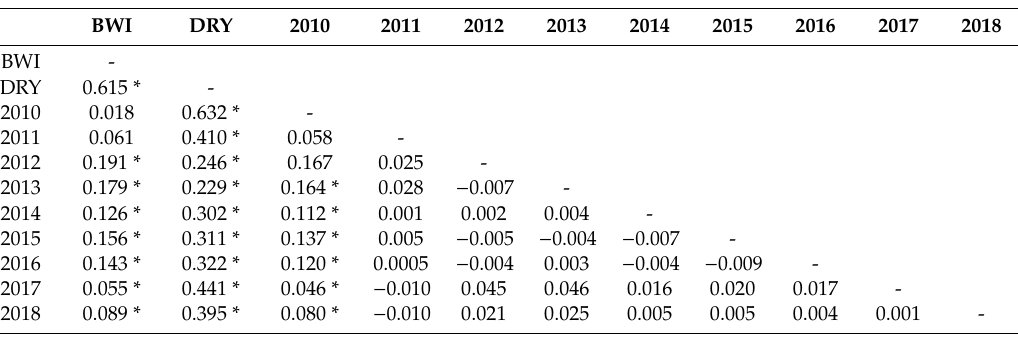
Table 3. Pairwise F ST estimates between founder populations of Bettongia lesueur , Barrow Island (BWI) and Dryandra (DRY), and samples taken from the Matuwa translocated site between 2010 and 2018 for SNP